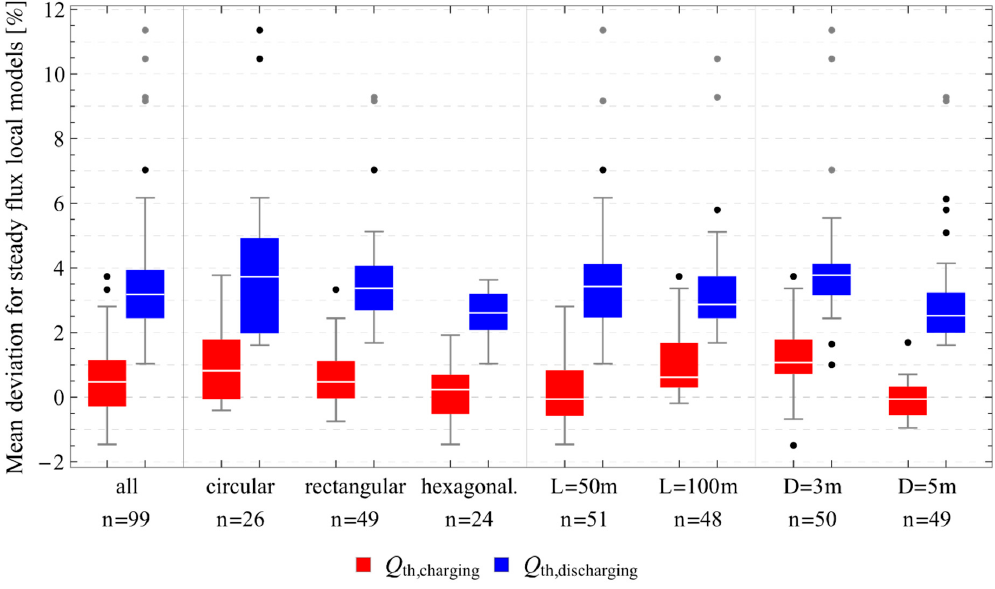
Figure 8. Impact of different parameters on the deviation of charged and discharged energy between FEFLOW and MoBTES models using a steady flux local model (L = BHE length, D = minimal BHE distance).